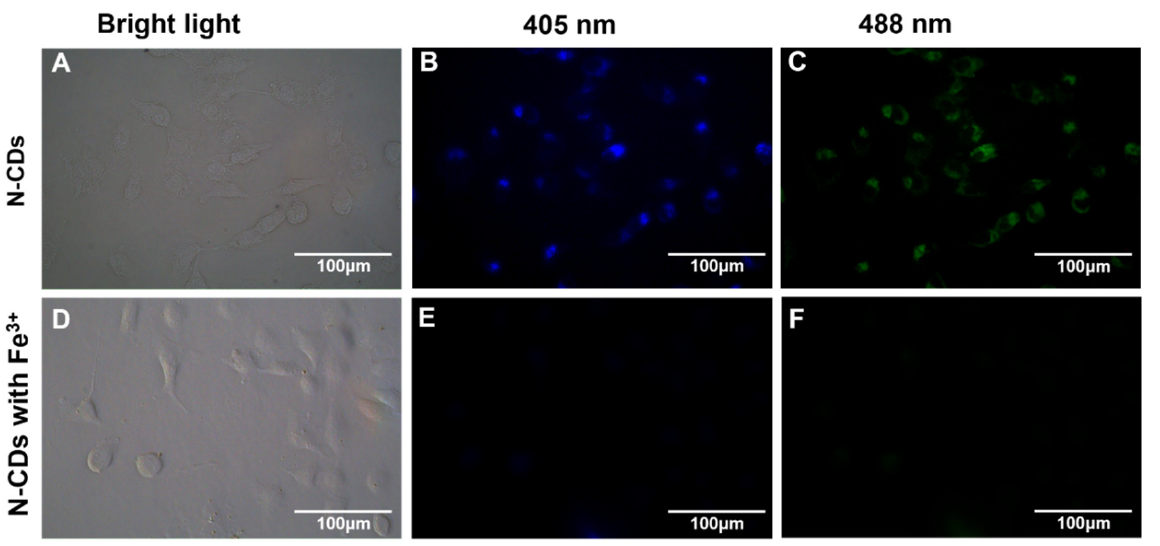
Figure 7. Fluorescence microscope images of A549 cells incubated with N − CDs (100 μ g ∙ mL − 1 ) in the absence and presence of Fe 3+ under bright field ( A , D ), excitation wavelengths of 405 nm ( B , E ), 488 nm ( C , F ) for each horizontal channel, respectively (scale bar: 100 μ m).